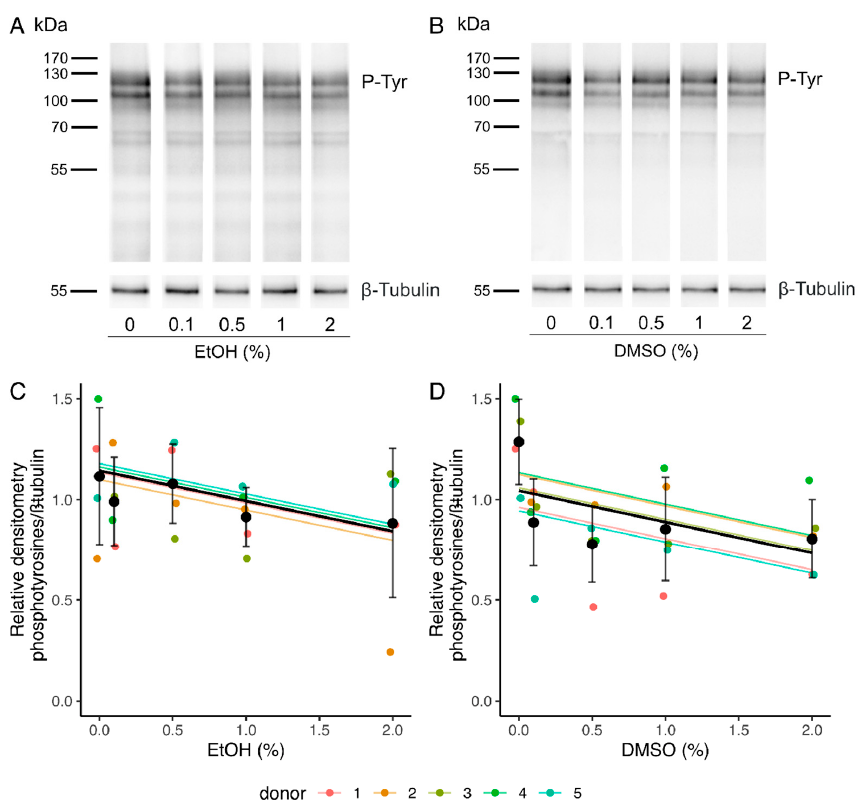
Figure 4. Influence of ethanol (EtOH) and dimethyl sulfoxide (DMSO) on sperm capacitation after a 4 h incubation. ( A , B ) Representative images of Western blot analyses of phosphotyrosilated proteins for spermatozoa incubated in the presence of EtOH ( A ) or DMSO ( B ). ( C , D ) Quantification of the level of phosphotyrosilated proteins in relative densitometry with respect to β -Tubulin for EtOH ( C ) and DMSO ( D ). Values for each replicate (n = 5) are highlighted by a dot whose color refers to a donor. Colored lines represent the model fit for each donor. Black dots represent mean values for each concentration ± SD. Black lines correspond to the mean effect across all donors (Tables 2 and S3).